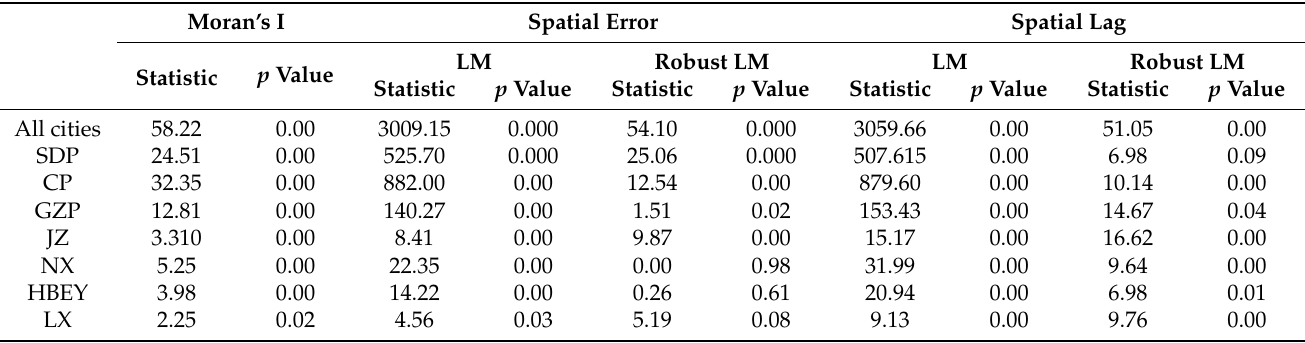
Table 5. LM test of spatial panel (conditional β